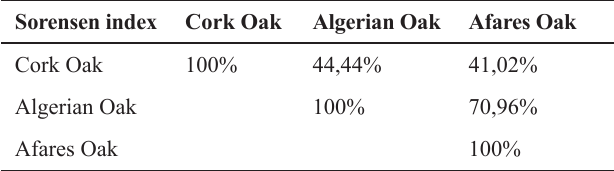
Table 3 . Sorensen similarity index values calculated for the two-to-one comparison of sampled environments in the Guerrouche forest (Algeria)